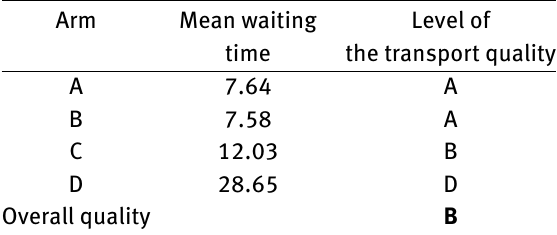
Table 9: Transport quality of each of the arms. Source: authors. Arm Mean waiting Level of time the transport